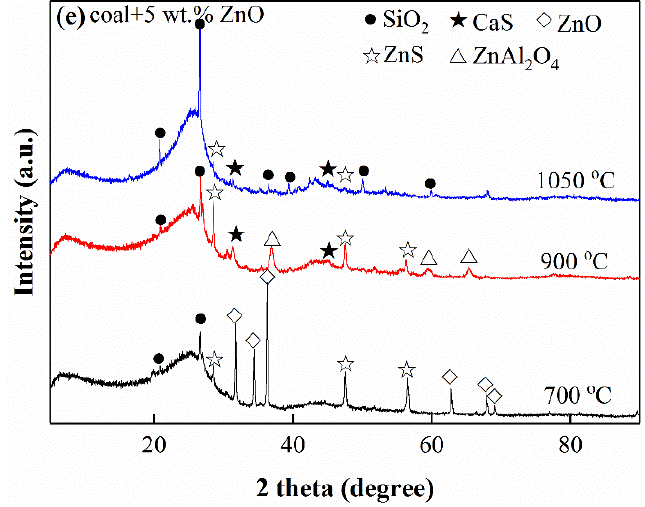
Figure 5. XRD patterns of coke generated by pyrolysis of coal containing 1 wt.% ( a ), 3 wt.% ( b ) and 5 wt.% ( c ) of WT-2, 1 wt.% ( d ) and 5 wt.% ( e ) of ZnO.